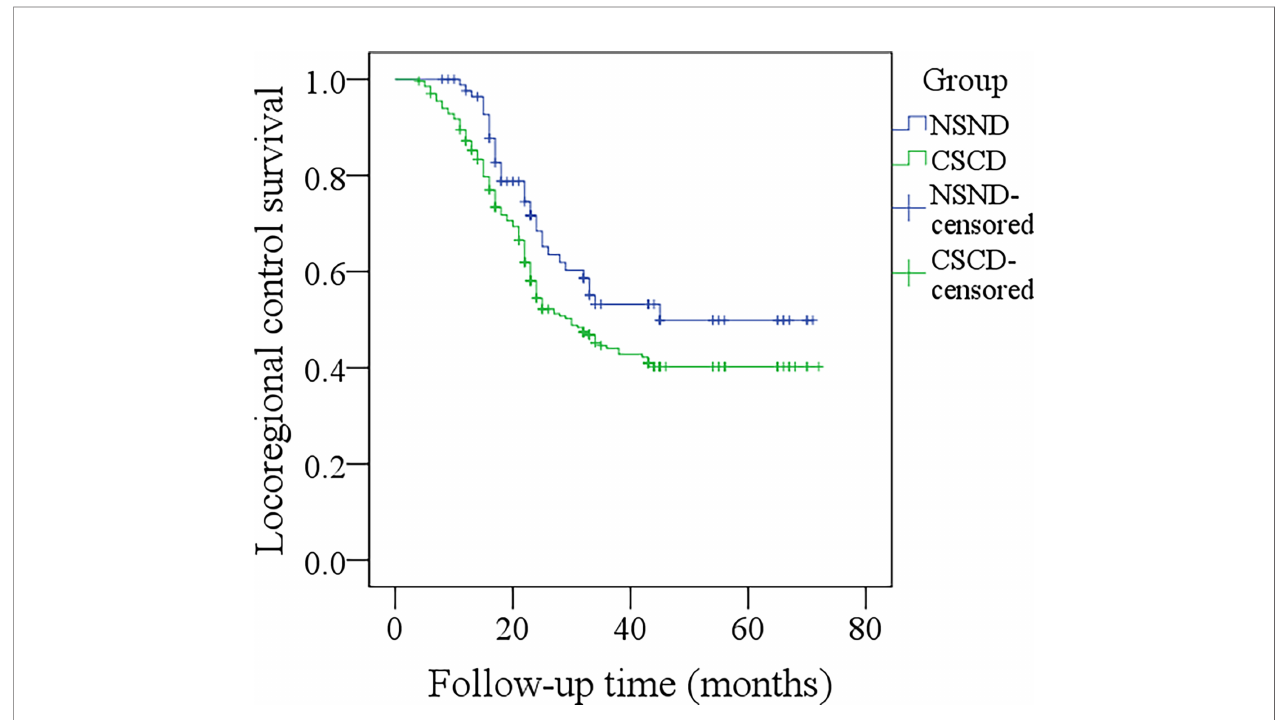
FIGURE 1 | Comparison of locoregional control survival between the non-smoker and non-drinker group and the current-smoker or current-drinker (CSCD) group (p =